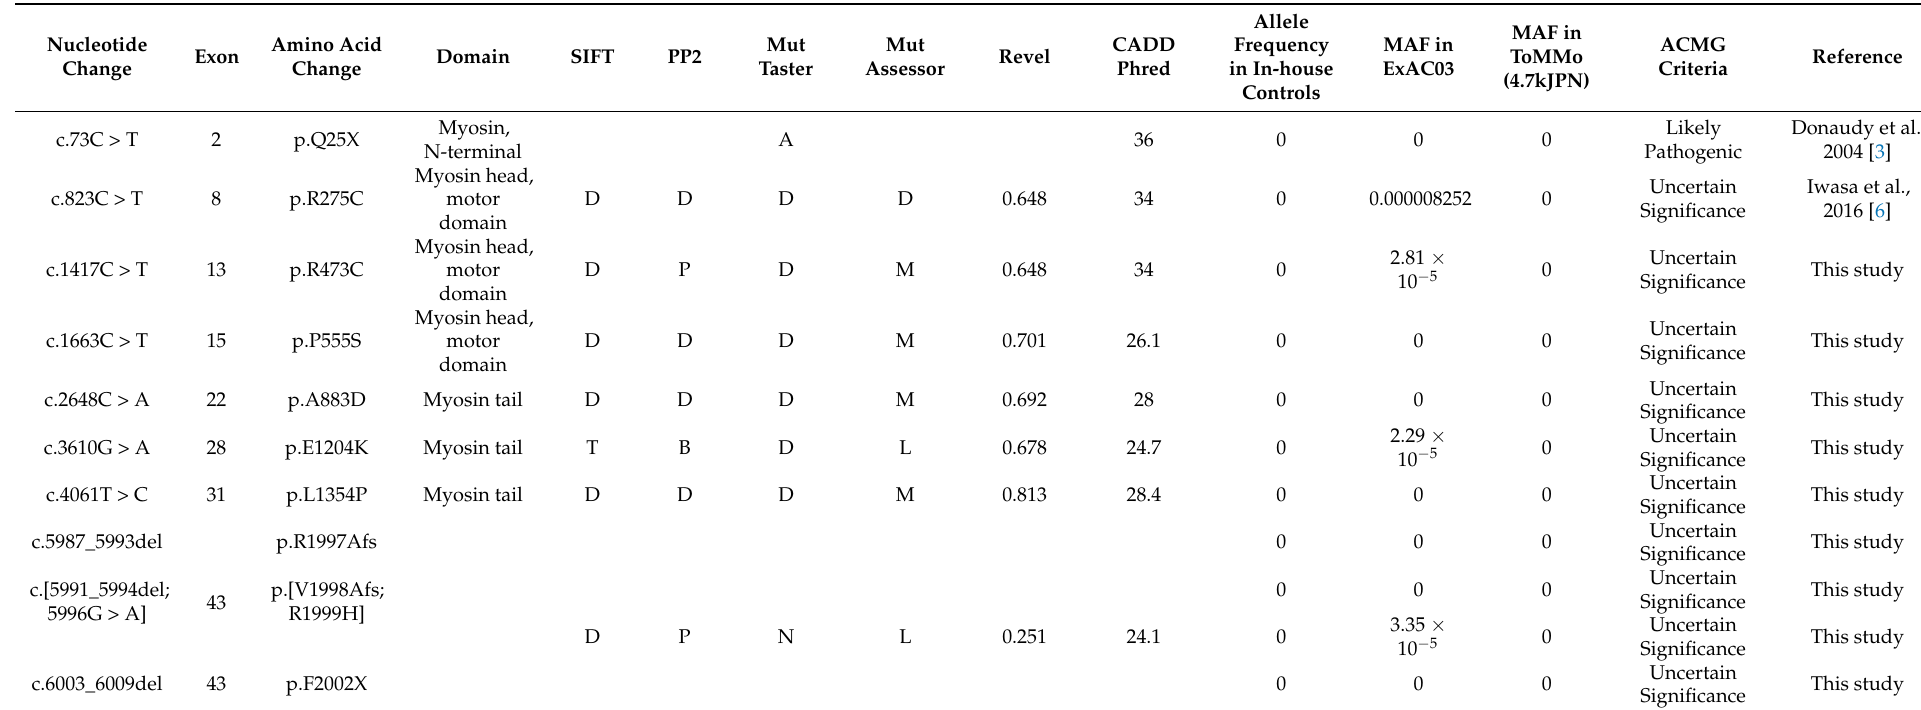
Table 2. Identified MYH14 variants and in silico predication score (all MYH14 variants are indicated in